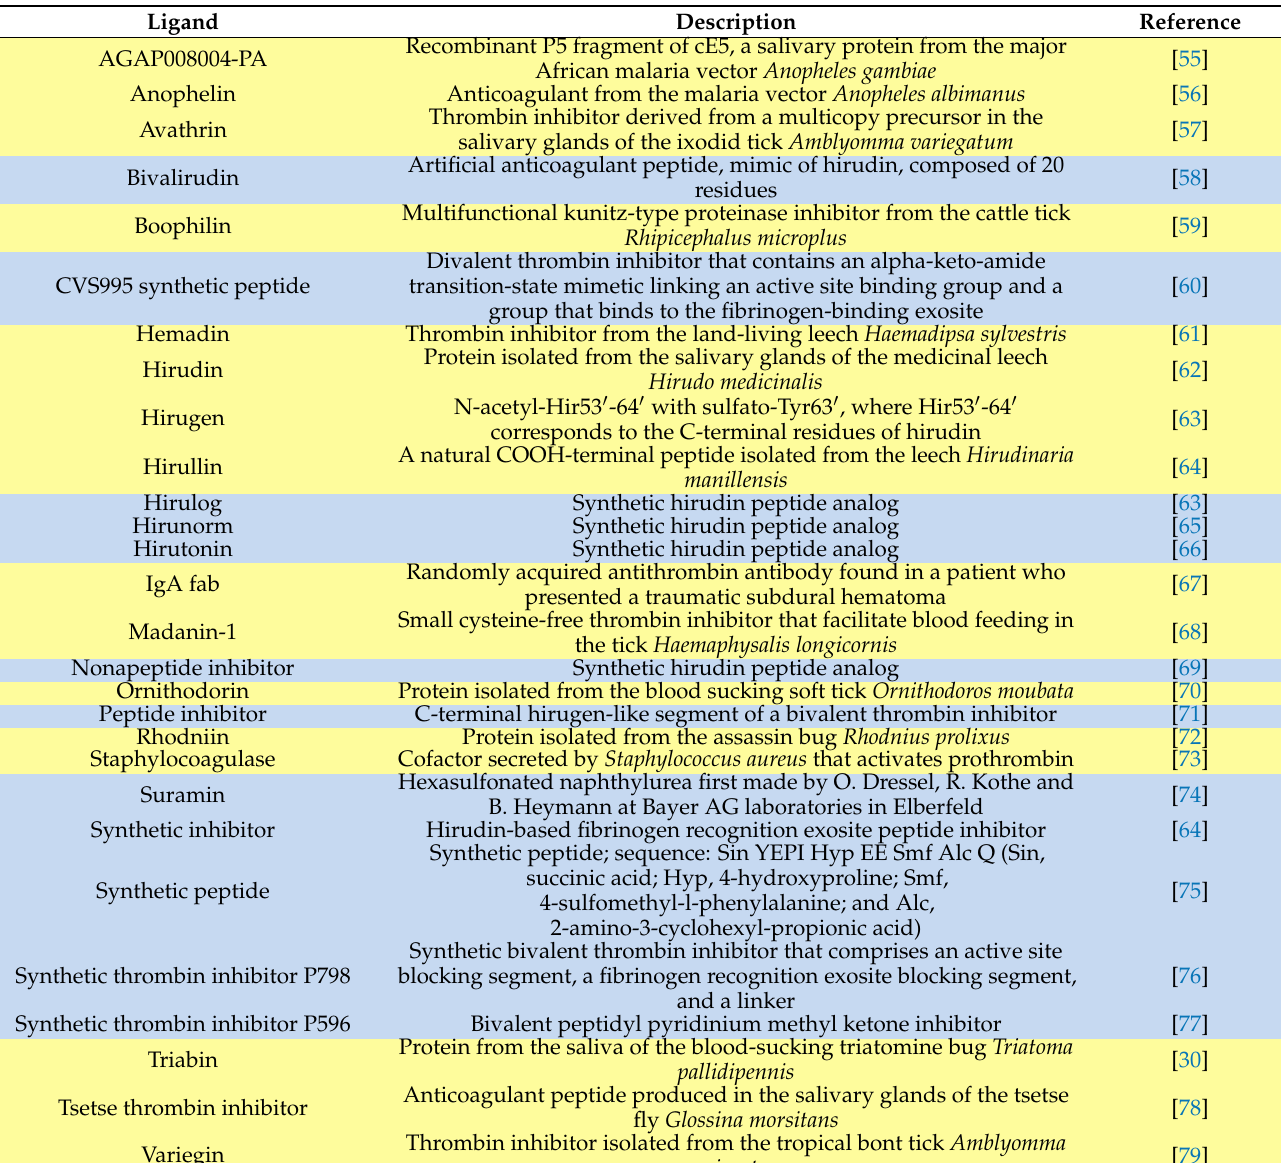
Natural (yellow) and synthetic (light blue) inhibitors of thrombin whose complexes have been structurally